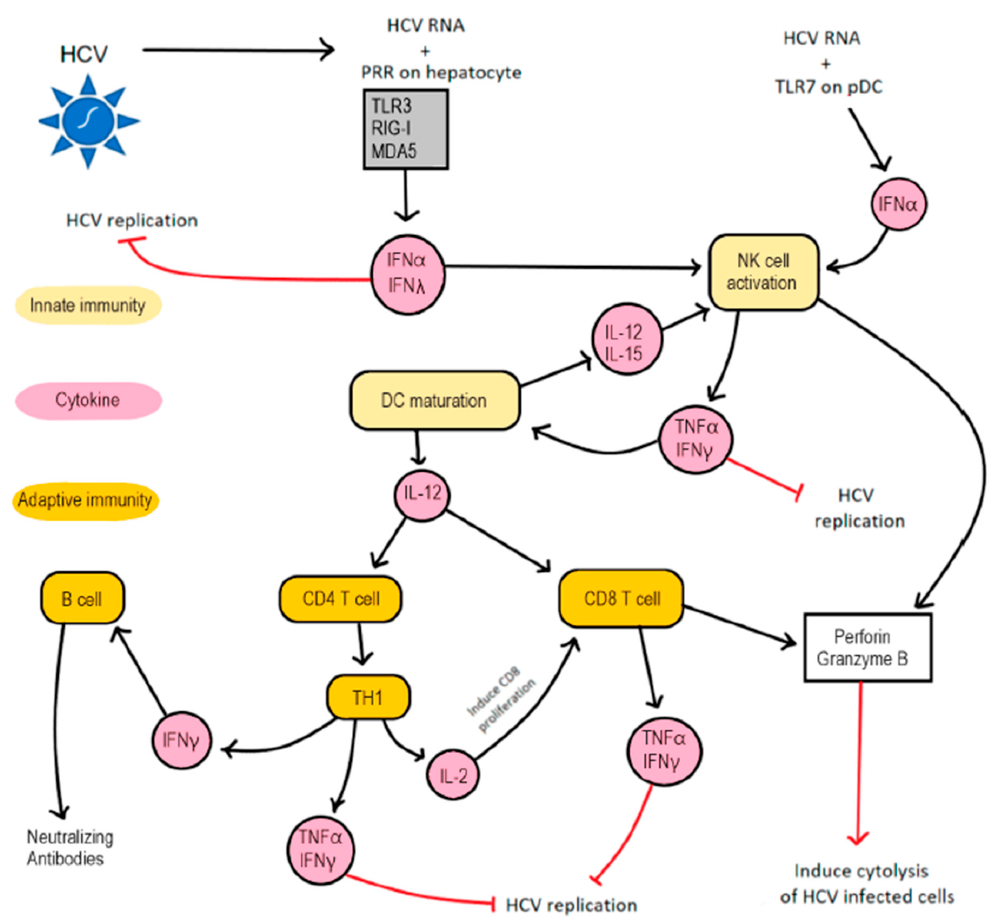
Figure 2. A host immune response to an HCV infection: The interaction between HCV and hepatocytes induces innate and adaptive immune responses. During an HCV infection of hepatocytes, HCV RNA engages TLR3, RIG-I, and MDA5 on infected hepatocytes as well as TLR7 on pDC to induce the secretion of type I and III interferons. Type I and III IFN inhibit HCV replication and activate NK cells. Activated NK cells produce IFN- γ and TNF α , which induce DC maturation and inhibit HCV replication. Matured DC produce IL-12 that induce the di ff erentiation of CD4 T cells and CD8 T cells into Th1 cells and Cytotoxic T cells, respectively. Additionally, IL-12 and IL-15 secreted by DC activate NK cells. Th1 cells secrete IL-2, IFN- γ , and TNF α . IL-2 induce the proliferation of CD8 T cells, whereas IFN- γ and TNF α inhibit HCV replication without inducing a cytolysis of HCV-infected cells. Furthermore, IFN- γ produced by Th1 cell induce the di ff erentiation of B cells into plasma cells that produce neutralizing antibodies. Finally, perforin and granzyme B produced by CTL and activated NK cells induce the cytolysis of HCV-infected